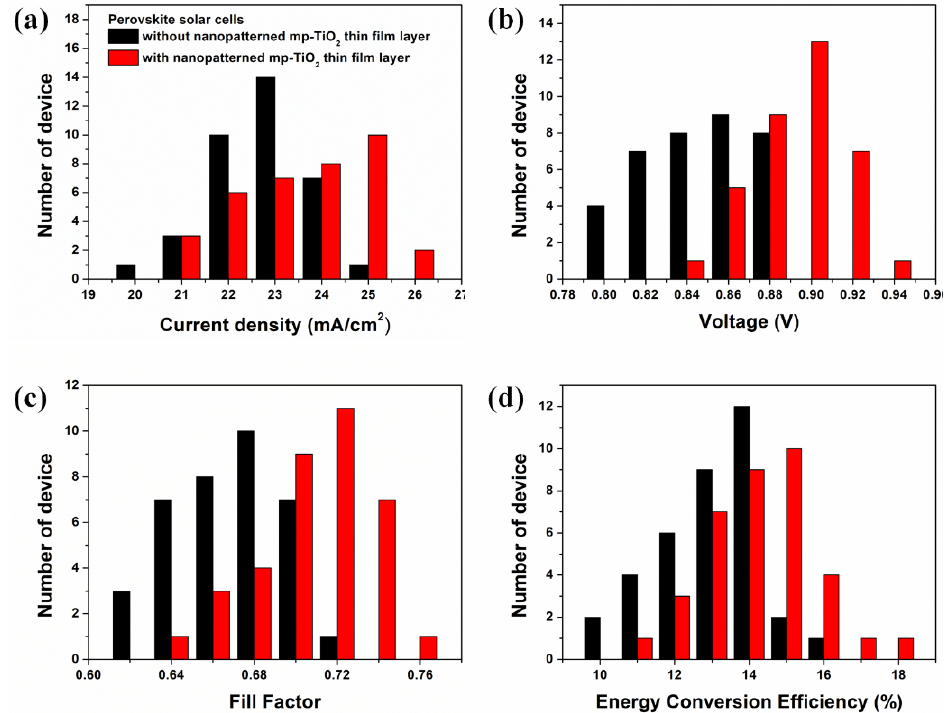
Figure 10. Histograms of perovskite solar cells without a nanopatterned (black) and with a nanopatterned (red) TiO 2 thin-film layer. ( a ) is current density, ( b ) is voltage, ( c ) is fill factor, and ( d ) is energy conversion efficiency.